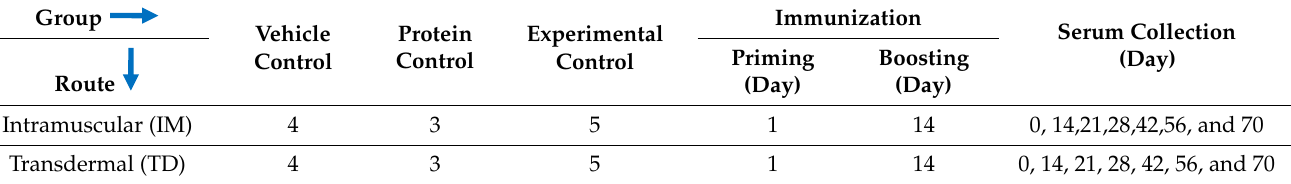
Table 1. Grouping of animals for immunization protocol.